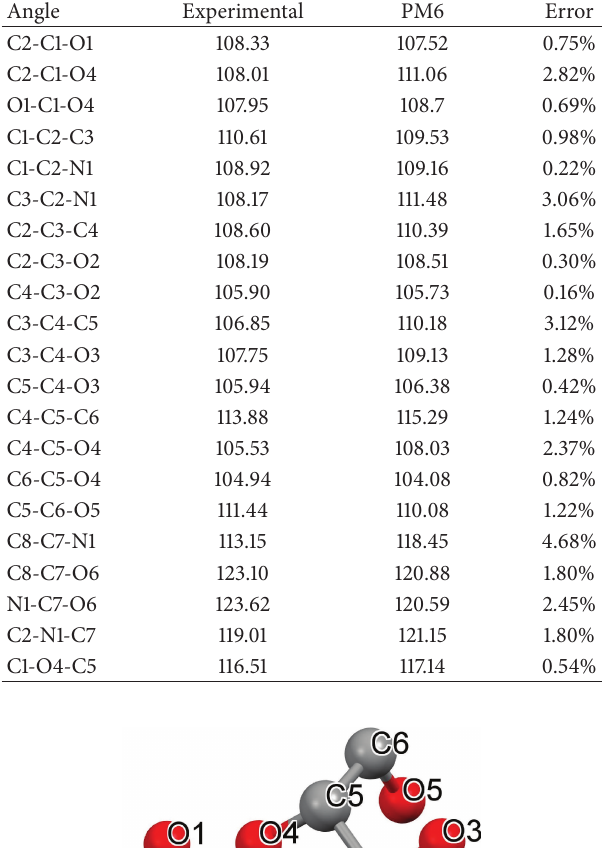
Table 2: Comparison of the experimental bond angles (in degrees) with those of the geometry optimized with the PM6 method. UME = 1.54%.